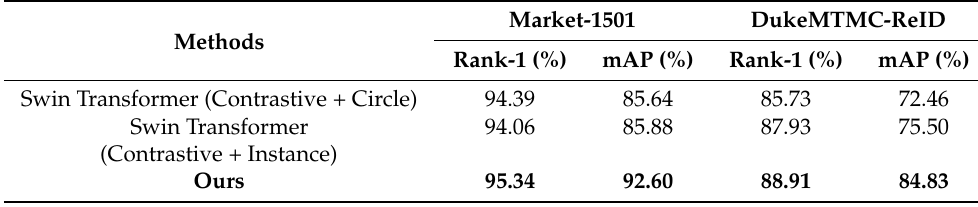
Table 3. Ablation studies of TL-TransNet with other